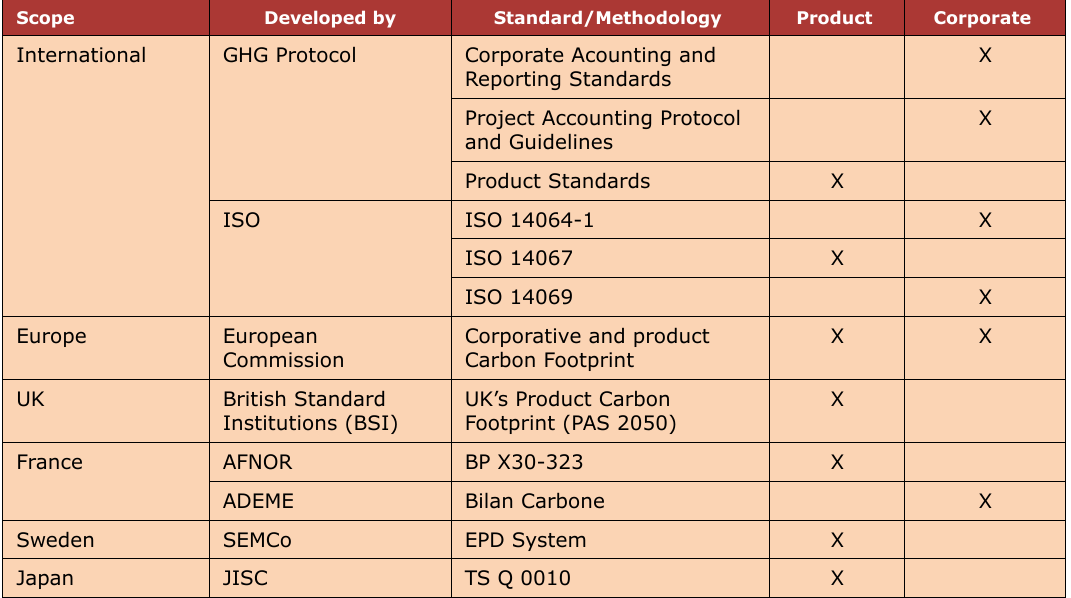
Table 1. Examples of methodologies and approaches for calculating CF of products and organizations (European Commission, 2011; Finkbeiner, 2009; Pandey, Agrawal & Pandey,